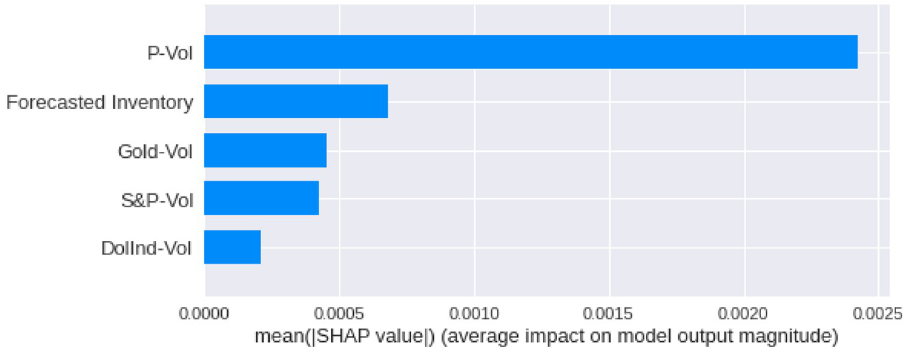
Fig 24. Mean Shapley values for the fifth previous day using Nadam